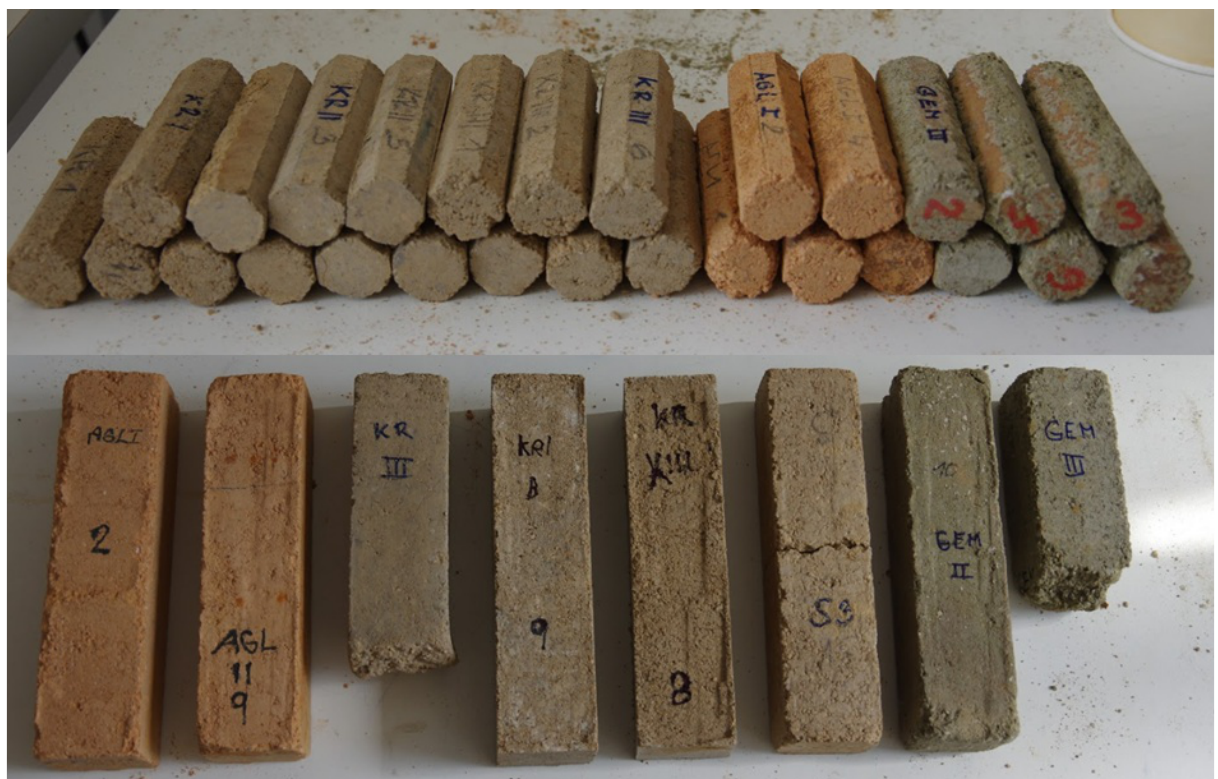
Figure 2. Prefabrication of the specimens in laboratory conditions.